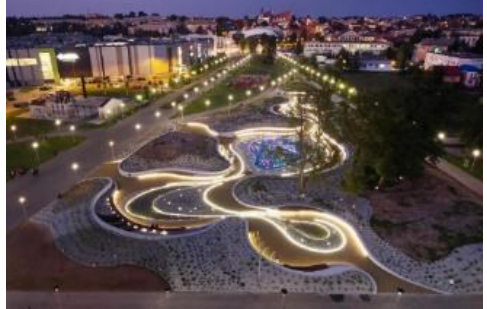
Figure 3: Jaworznickie Planty Water Playground, Jaworzno, Poland [URL3]